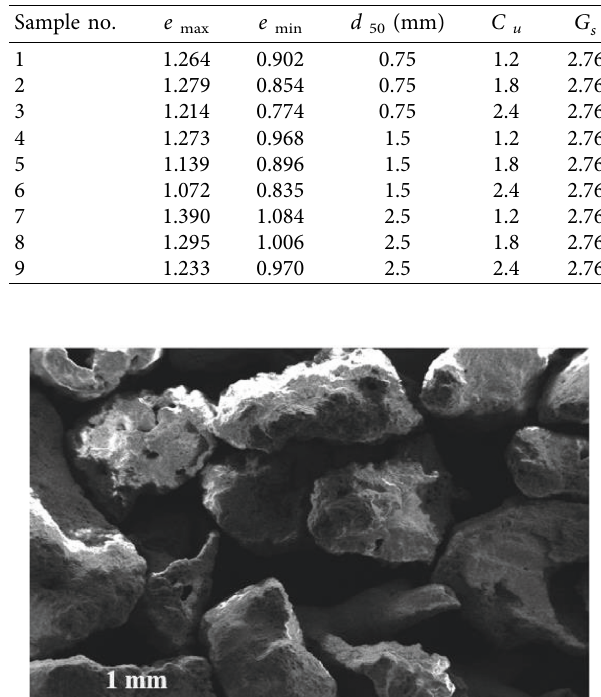
Figure 1: Grain size distribution curves of calcareous sand with varying gradation conditions. Table 1: The physical parameters of calcareous sand with different gradation conditions.